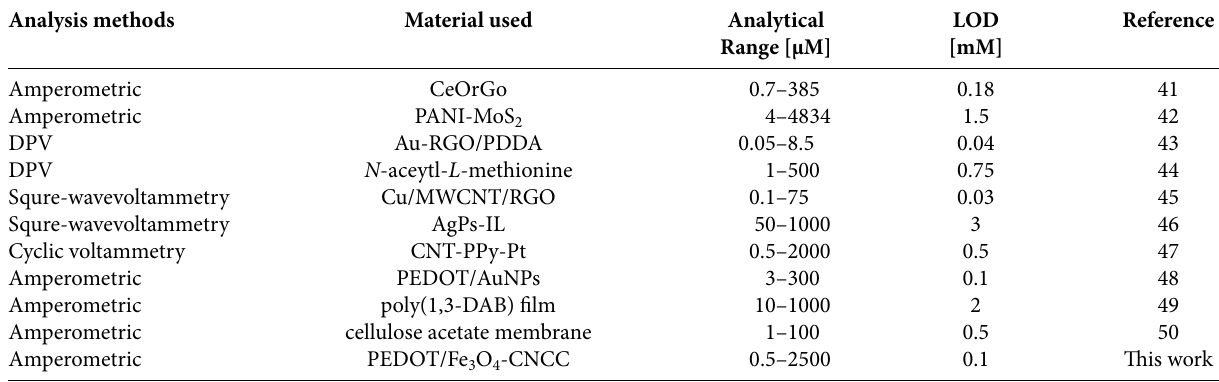
Table 1. Comparison of the performances of different electrochemical sensors for the determination of nitrite.